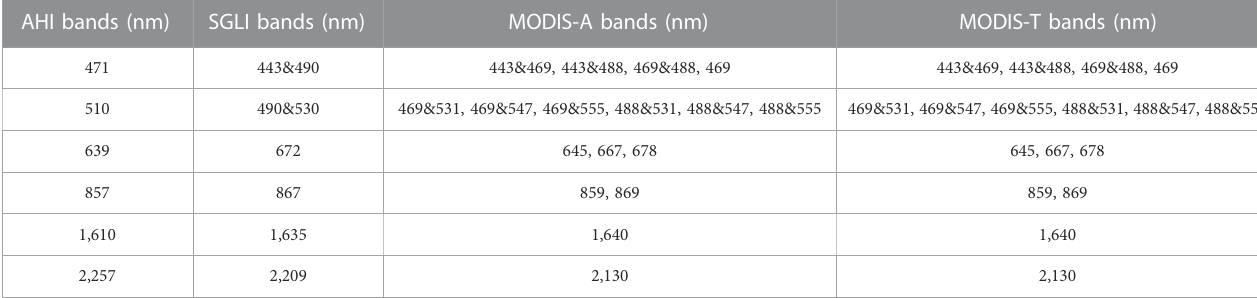
TABLE 1 A list of the combinations of SGLI, MODIS-A, and -T bands used for estimating re fl ectance in AHI bands. AHI bands